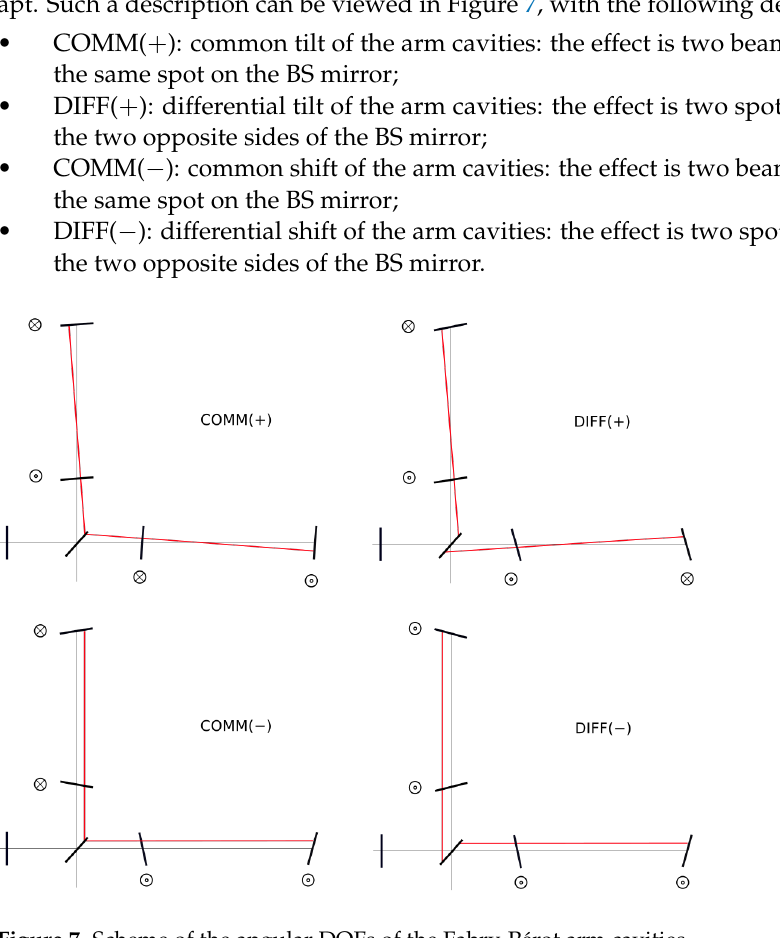
Figure 7. Scheme of the angular DOFs of the Fabry-Pérot arm